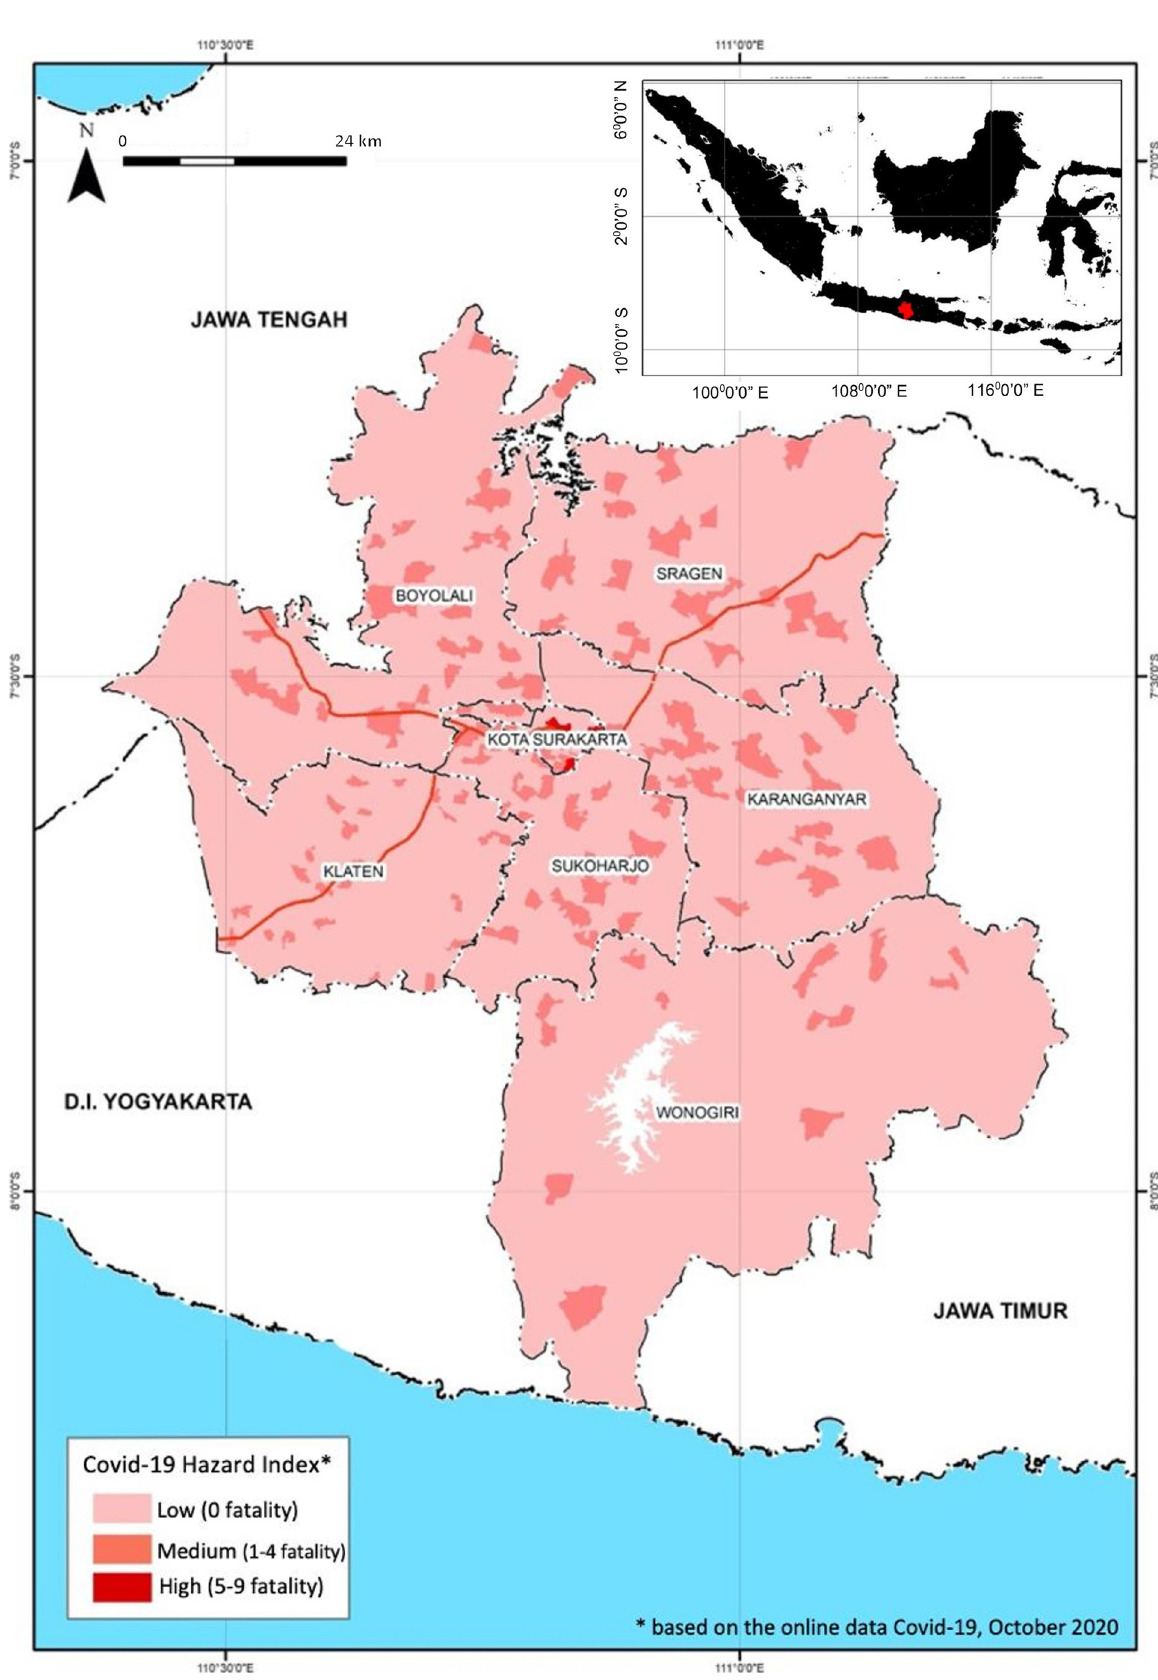
Fig. 6. COVID-19 hazard index of Subosukowonosraten (Greater